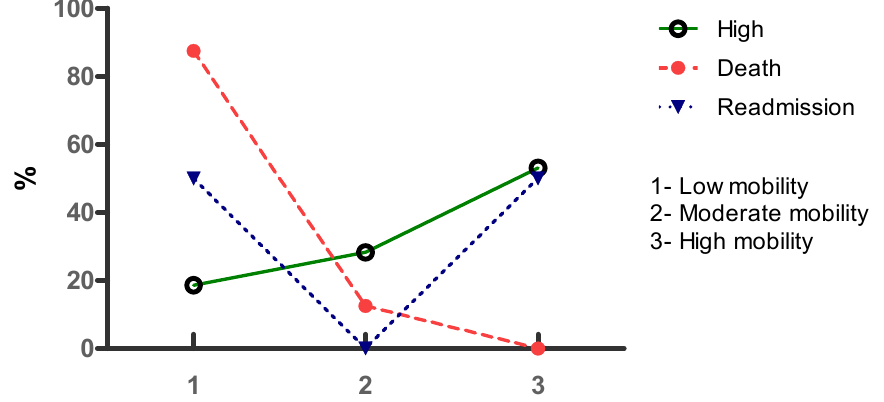
Figure 2. Discharge, death, and readmission according to the mobility level of individuals admitted to an ICU.